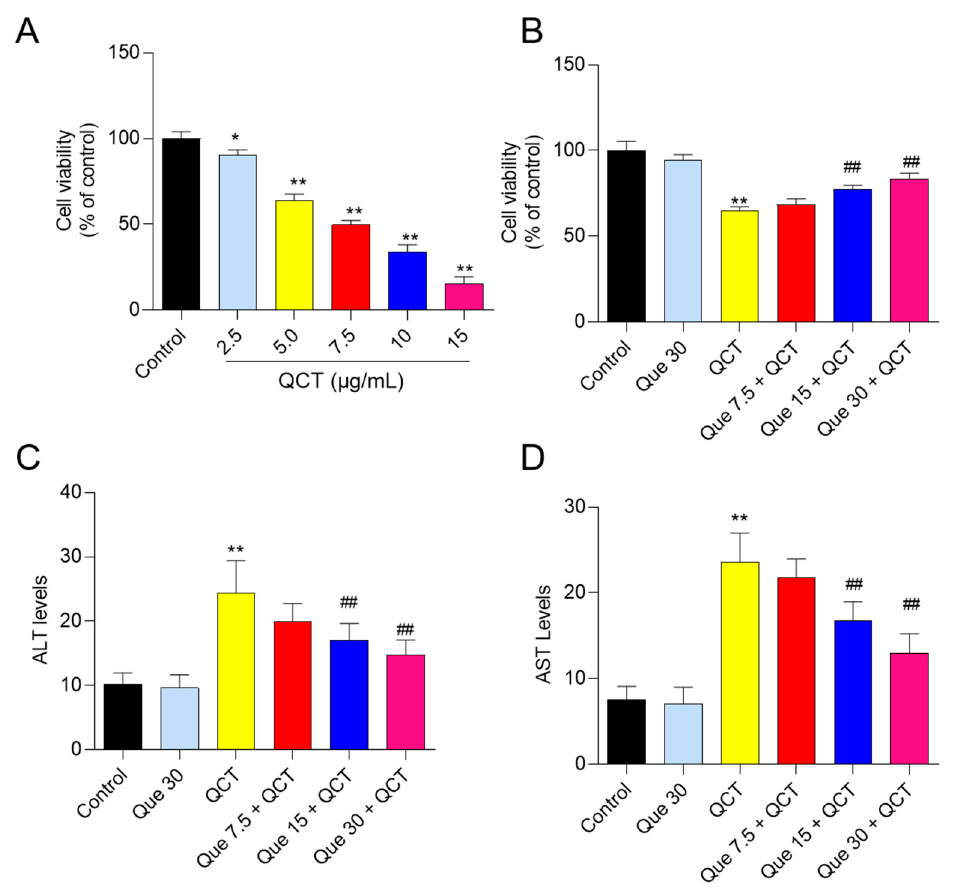
Figure 2. The effect of QCT exposure on cell viabilities and the protective effect of quercetin supplementation in human L02 cells. ( A ), L02 cells were treated with QCT at various concentrations (i.e., 2.5, 5, 7.5, 10, and 15 μ g/mL) for 24 h, and cell viabilities were measured using the CCK ‐ 8 method. ( B ), L02 cells were pretreated with quercetin at final concentrations of 7.5, 15, and 30 μ M for 2 h, followed by co ‐ treatment with QCT at final concentrations of 5 μ g/mL for an additional 24 h. Finally, cell viabilities were measured. ( C , D ), the effect of quercetin supplementation on the levels of ALT ( C ) and AST ( D ) activity in the culture medium of human L02 cells. All results were presented as mean ± SD, from three independent experiments ( n = 3). * p < 0.05, ** p < 0.01, compared to the vehicle control group; # p < 0.05, ## p < 0.01, compared to the QCT ‐ alone group. QCT, quinocetone; Que, quercetin.